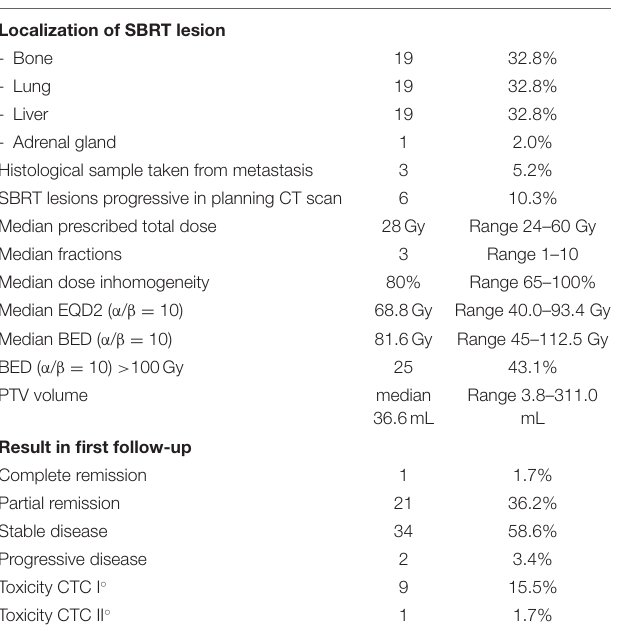
TABLE 3 | Analysis of the SBRT lesions.